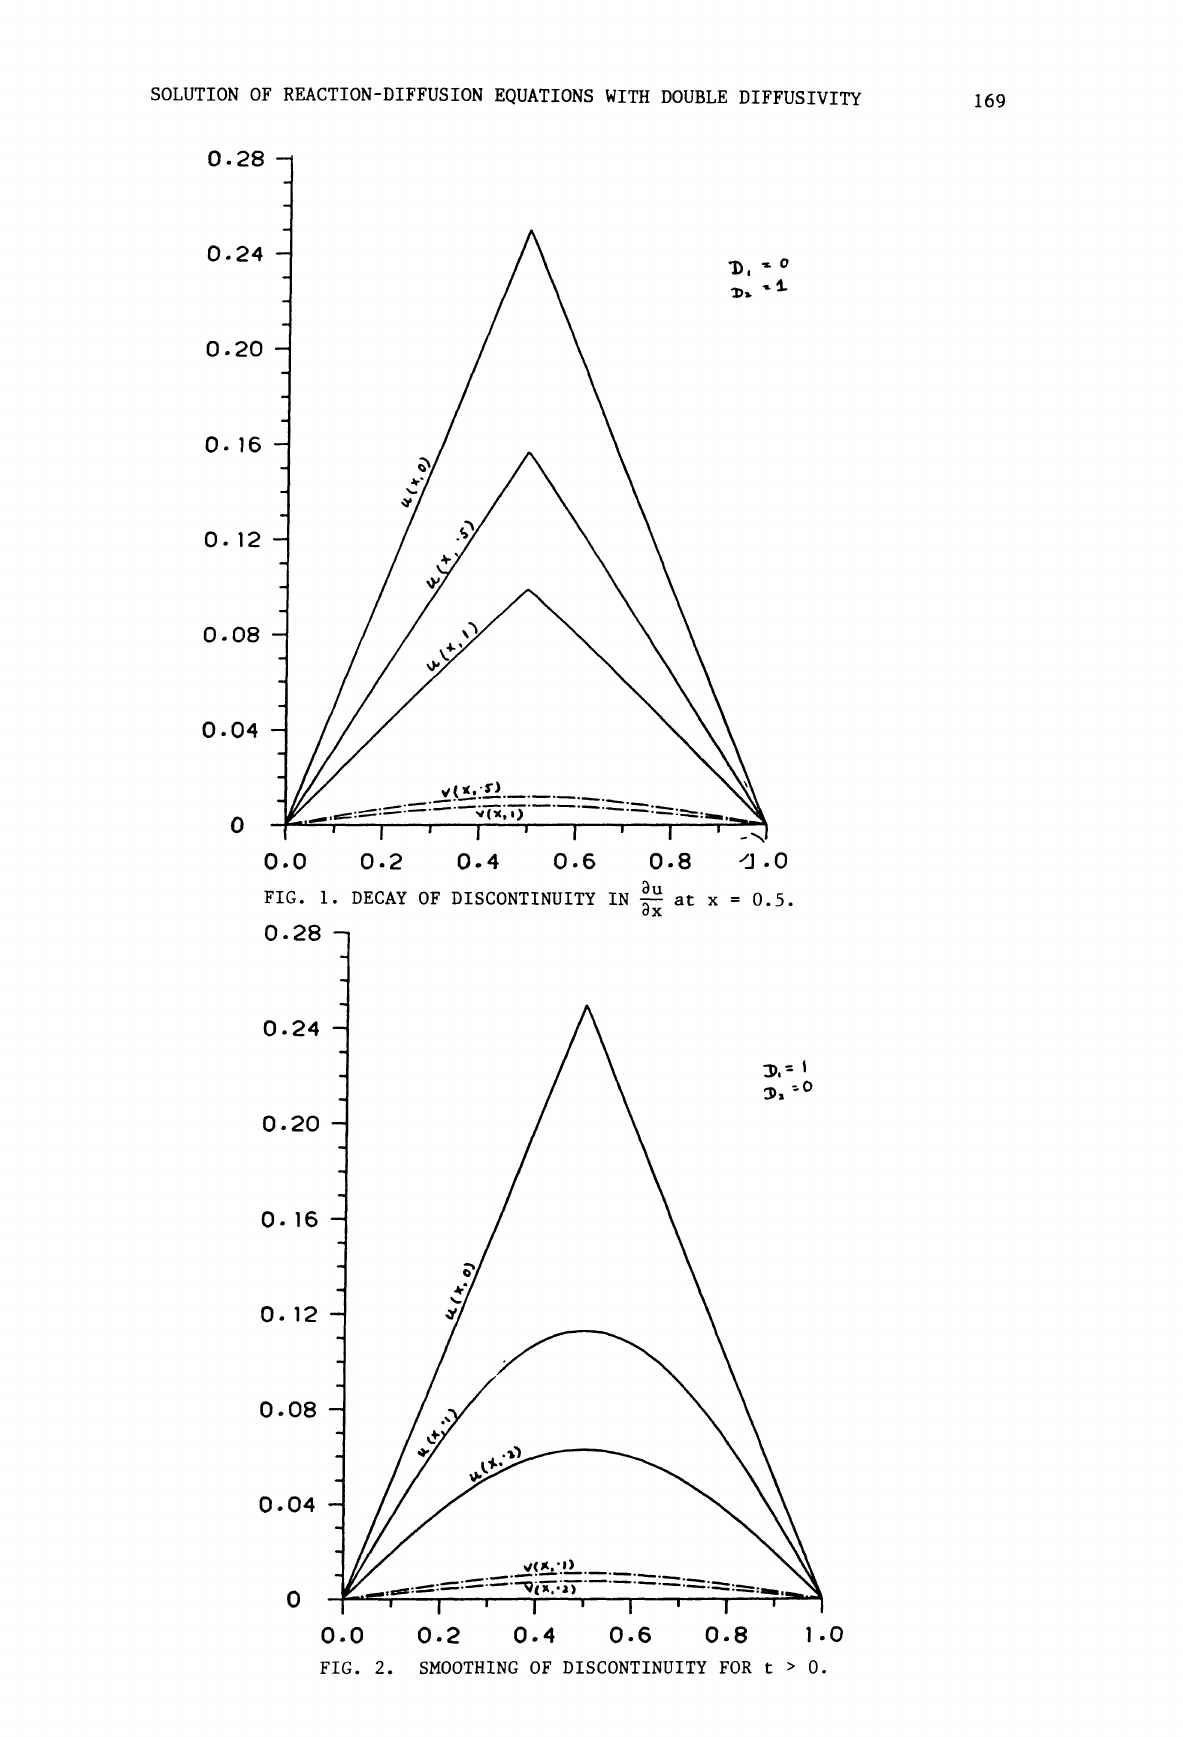
FIG. I. DECAY OF DISCONTINUITY IN at x